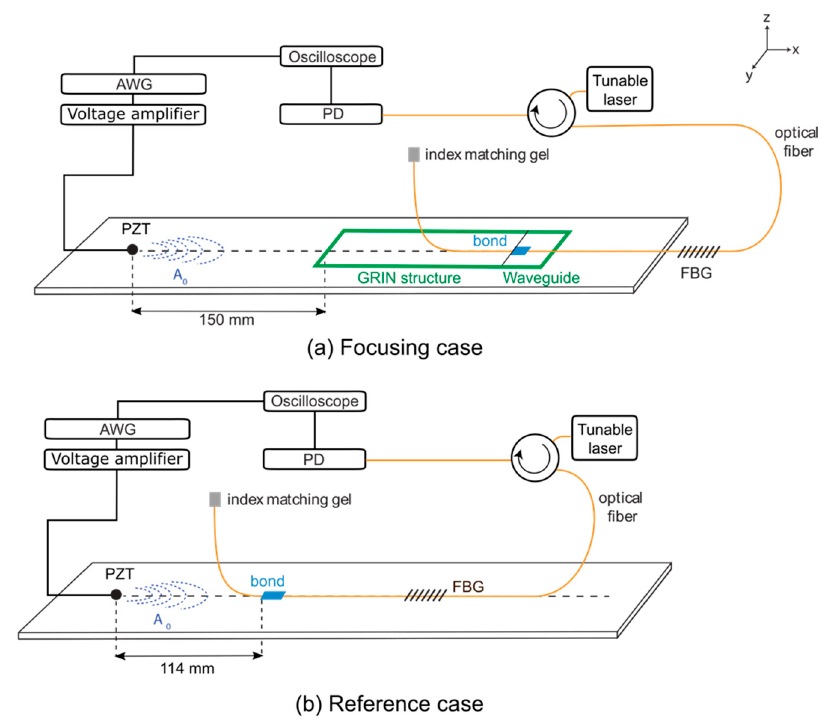
Figure 8. Experimental setup for measuring the amplitude of A 0 Lamb wave extracted from aluminium plate ( a ) with and ( b ) without amplification by the GRIN structure with waveguide channel. The FBG had a length of 10 mm and was written in a 125 µm diameter SMF-28 optical fiber with a 15 µm thick polyimide coating. The FBG sensor was interrogated based on the edge-filtering method [11]. The narrowband output of the tunable laser (TUNICS PLUS ® ) was initially set to the midpoint of the FBG ascending edge of the reflected spec- trum. The variation of axial strain in the optical fiber due to the L 01 mode induced a wave- length shift in the FBG reflected spectrum, which produced a change in the portion of the light reflected from the FBG and, therefore, a variation in the optical power measured at the photodetector. The change of voltage was converted to strain by first measuring the reflected spectrum by sweeping the tunable laser output and calculating the slope of the